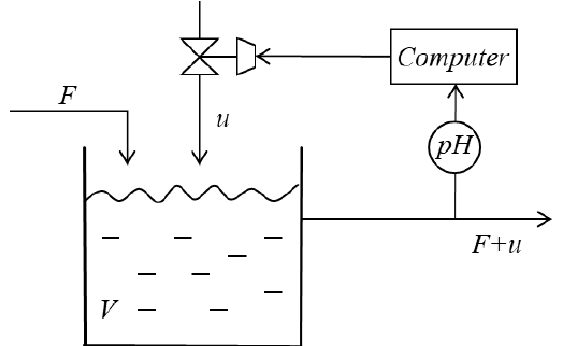
Figure 2. Schematic diagram of the pH process.